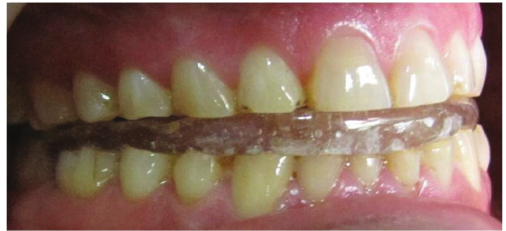
Figure 5: Occlusal splint in place.